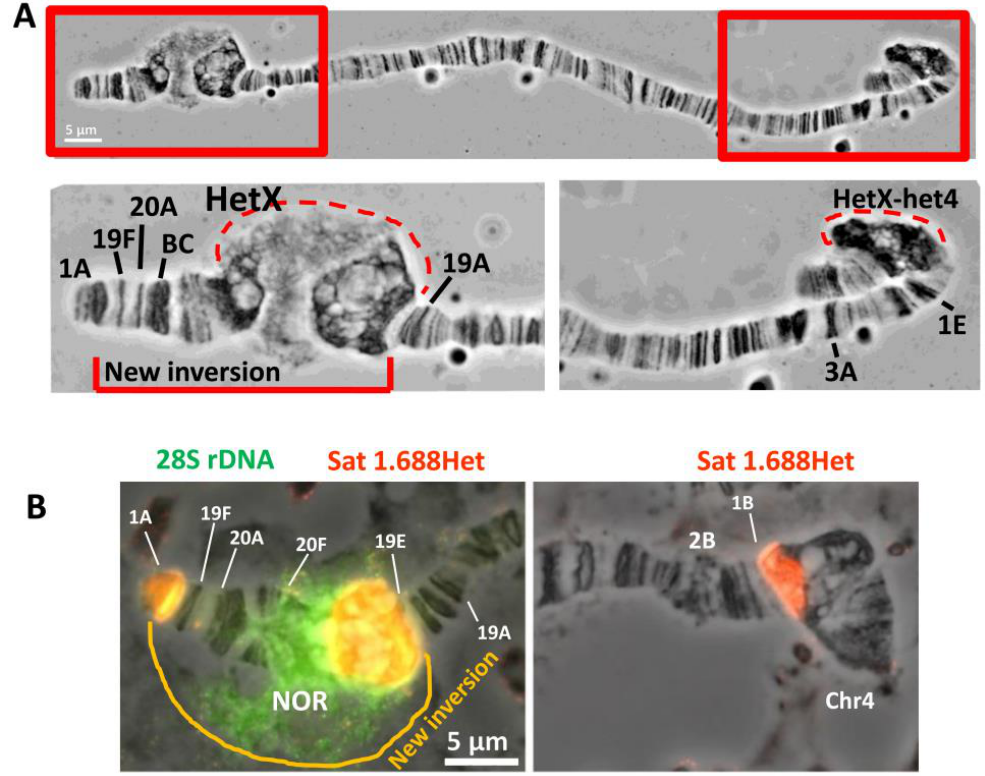
Figure 1. Detection and cytological mapping of the new X-chromosomal eu/heterochromatin inversion. ( A ) Polytene X chromosome of the new line carrying the Rif1 1 mutation, the In(1)sc 8 inversion, and the additional inversion named In(1)19EHet ( In(1)sc 8 + 19EHet; Rif1 1 ). The enlarged end segments of the chromosome highlighted in red rectangles are shown at the bottom. Of note, in Rif1 1 mutants, proximal X heterochromatin is always combined into a single block with chromosome 4 heterochromatin [38]. Aceto-orcein staining, phase contrast. ( B ) DNA FISH of the In(1)sc 8 + 19EHet ; Rif1 1 polytene X chromosome with probes to satellite 1.688Het (red) and 28S rDNA (green). To determine the origin of In(1)19EHet , we checked for the presence of the inversion in both the main and backup copies of the #798 line at the BDSC. Without the Rif1 mutant